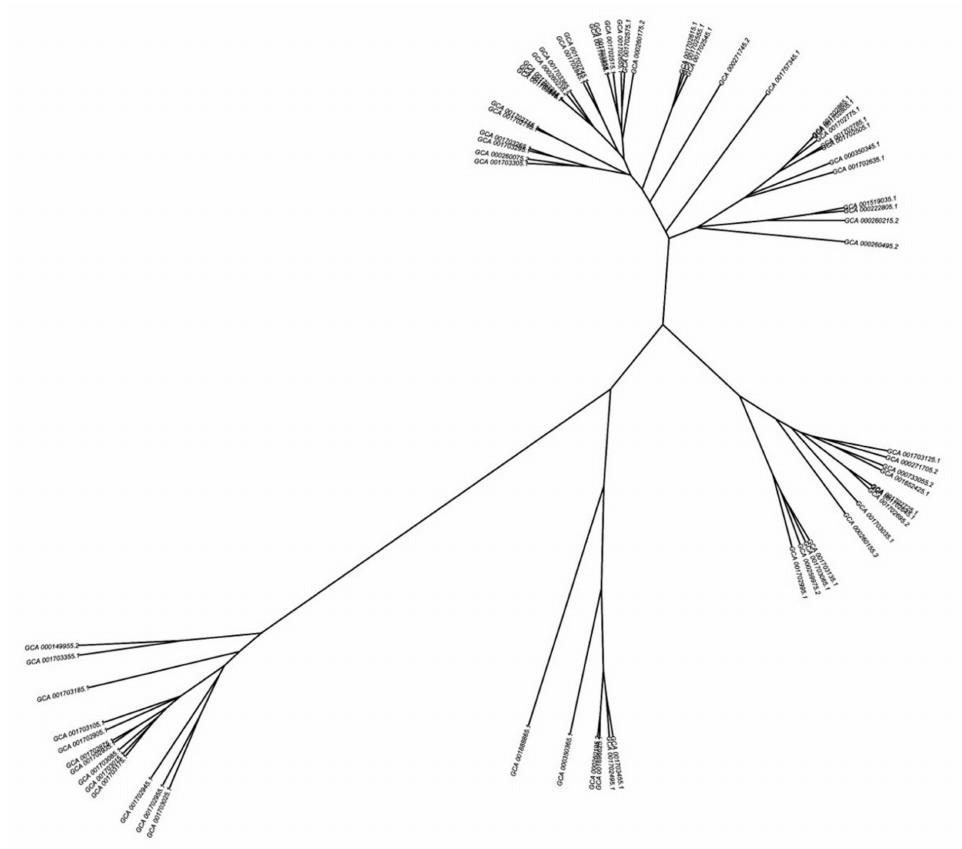
Figure 5. Effective differentiation of 66 strains of F. oxysporum by clustering of ePCR alleles of 75